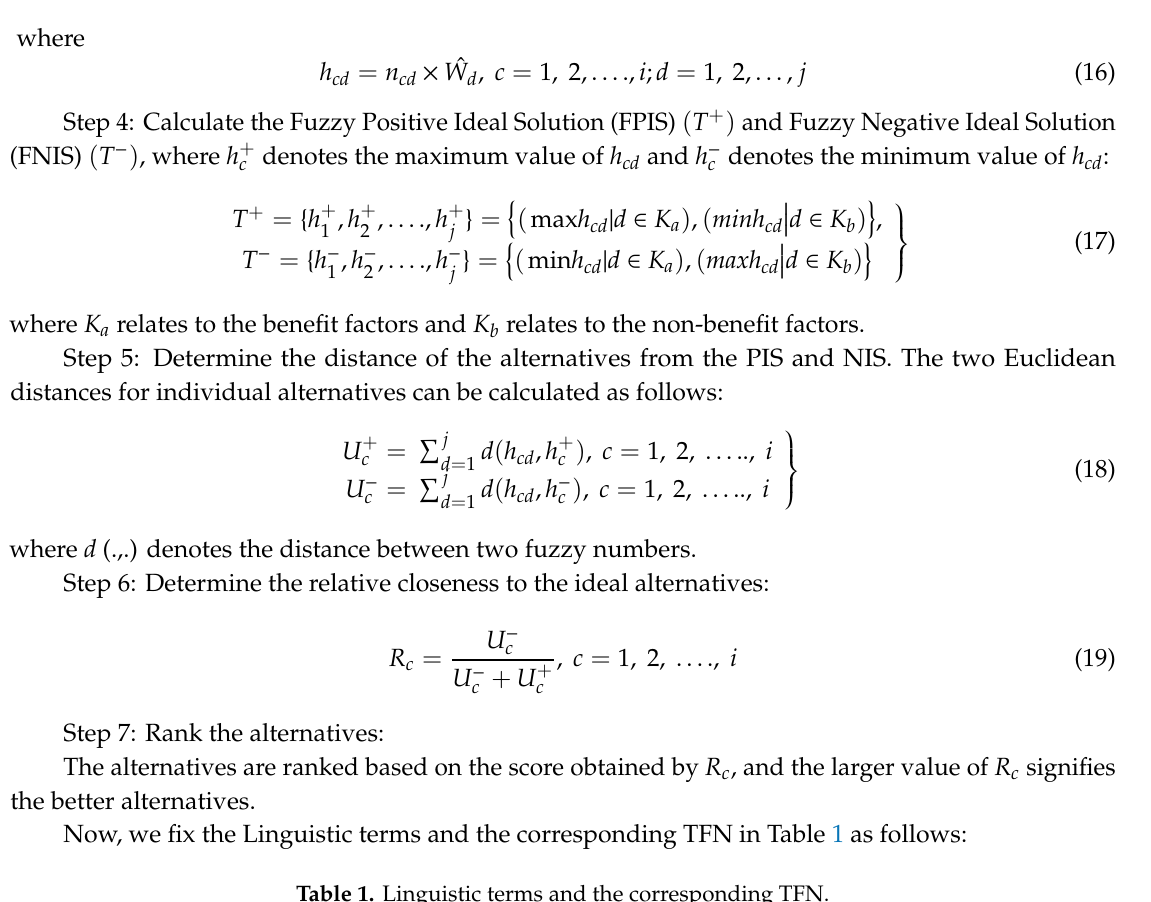
Table 1. Linguistic terms and the corresponding